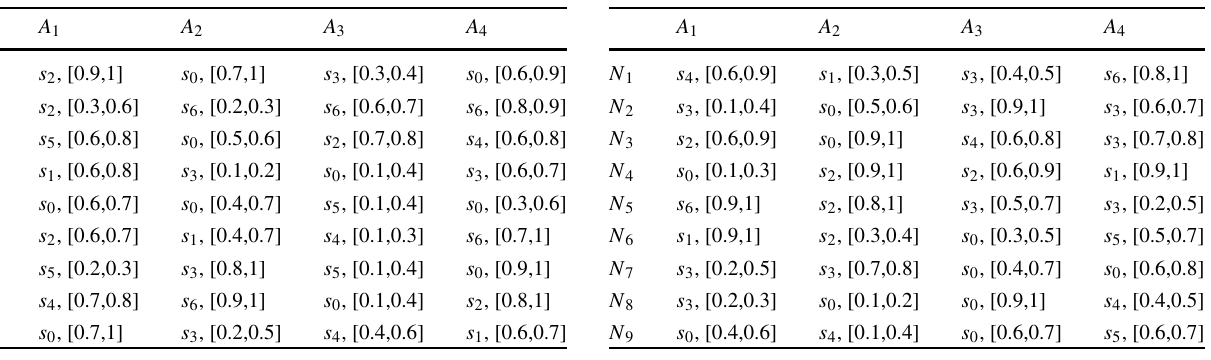
Table 4 The decision matrix with confidence interval values according to the third voting node